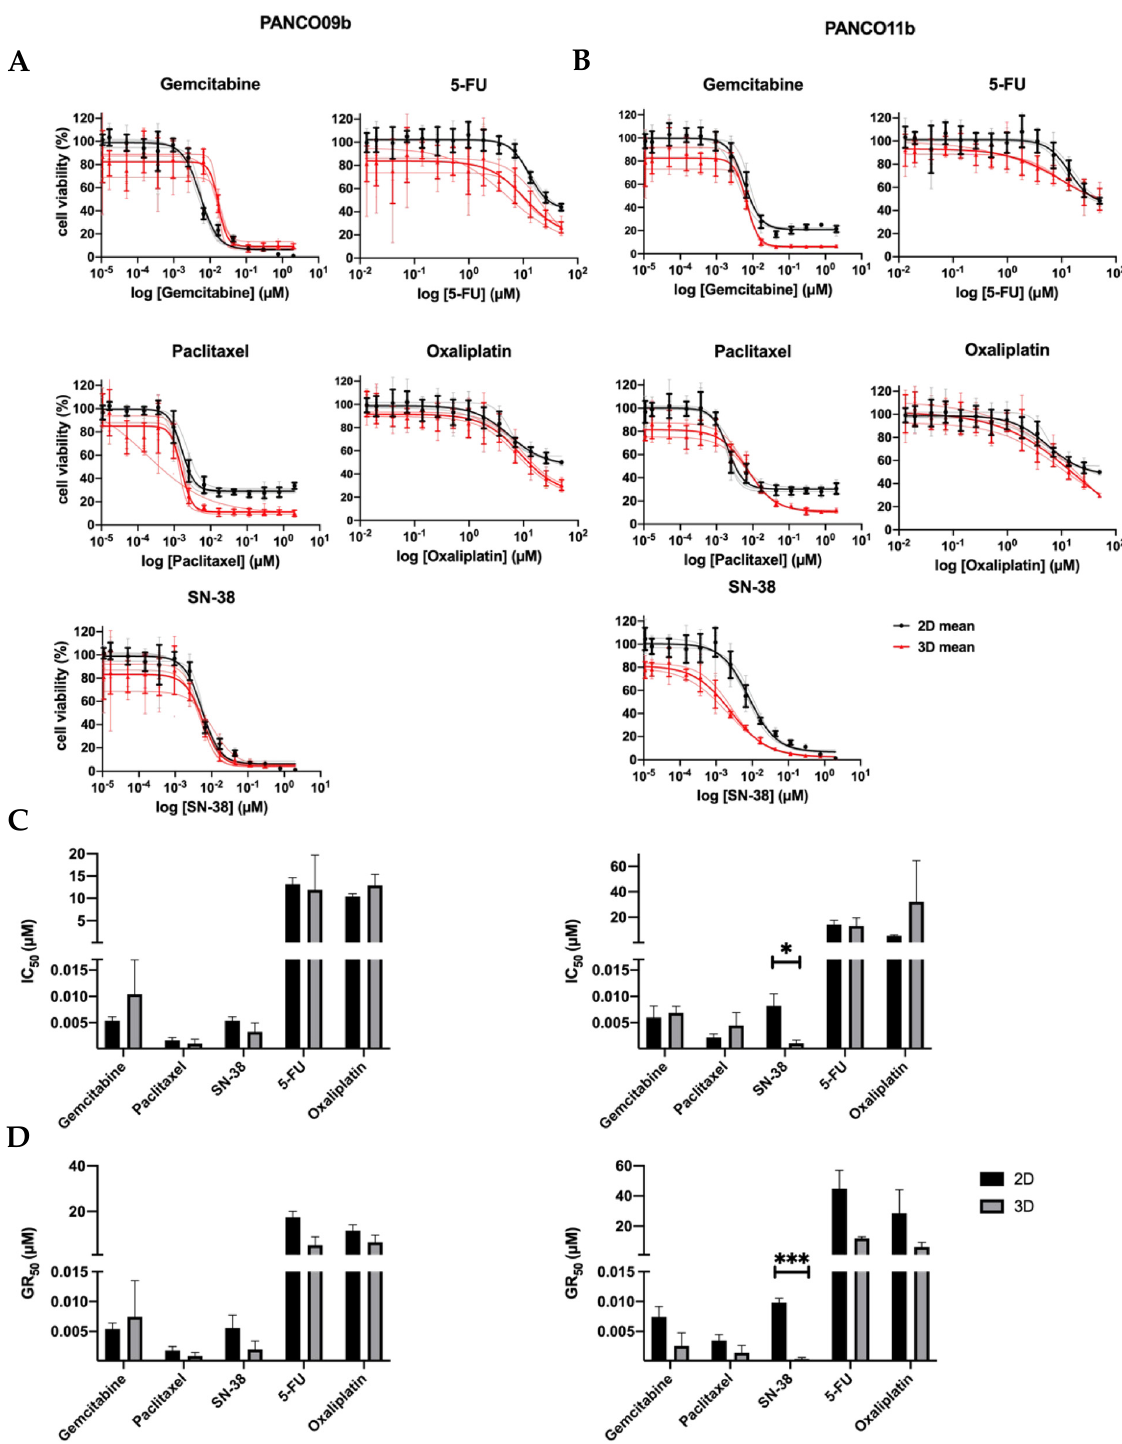
Figure 2. Chemosensitivity of PANCO09b and PANCO11b cells grown in adv.DMEM/F-12 in 3D vs. 2D. ( A ): Dose–response curves of PANCO09b grown in 3D vs. 2D. ( B ): Dose–response curves of PANCO11b grown in 3D vs. 2D. Thick, dark lines represent the mean and thin, light lines show the independent experiments in triplicates. ( C ): Bar graph of IC 50 values of PANCO09b and PANCO11b grown in 3D vs. 2D. ( D ): Bar graph of GR 50 values of PANCO09b and PANCO 11b grown in 3D vs. 2D. Data are presented as mean ± SD of three independent experiments performed in triplicate. Independent sample t -test was performed to assess differences. * = p < 0.05, *** = p <